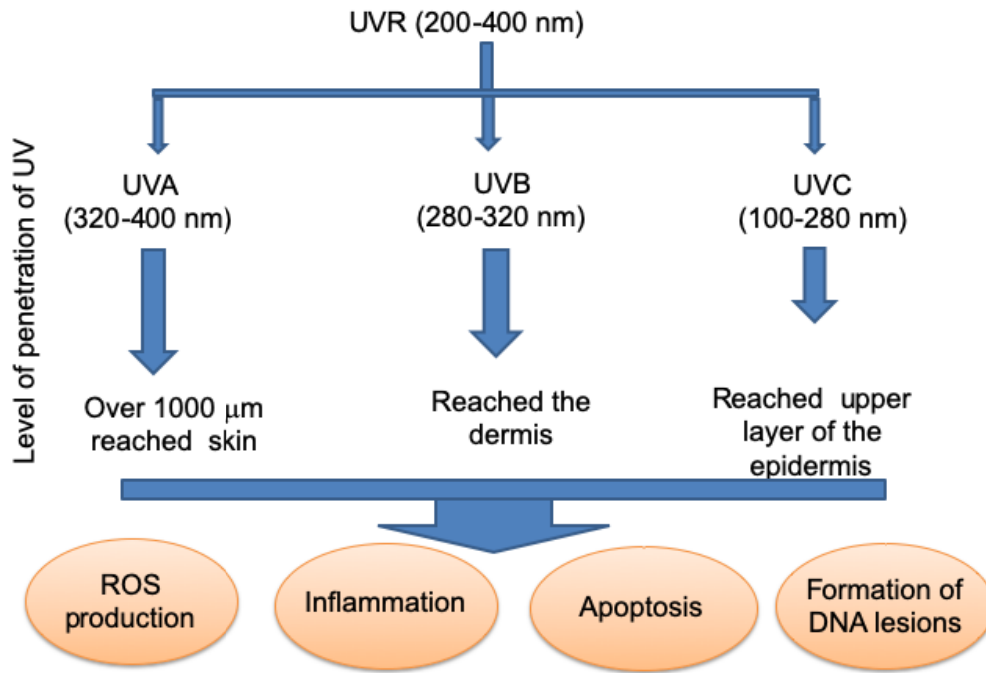
Figure 2. Ultraviolet radiation (UVR) with wavelengths between 200–400 nm is categorized into UVA, UVB, and UVC and can damage human skin. UVA penetrates the underlying sub-cutaneous tissues, UVB can reach the dermis, while UVC can only penetrate the upper layer of the epidermis. The exposure of the human skin to natural ultraviolet radiation (especially UVB) or artificially-generated UVR, produces damage caused by the production of reactive oxygen species (ROS), inflammatory processes, accelerated apoptosis, and the formation of DNA photo lesions.